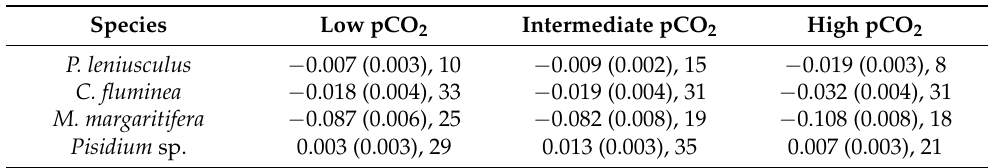
Table 2. Net calcification rates (fractional change in buoyant or wet weight normalized to a 30-day growth interval) in each treatment for each species during the experiment. Values reported are mean (standard error), sample